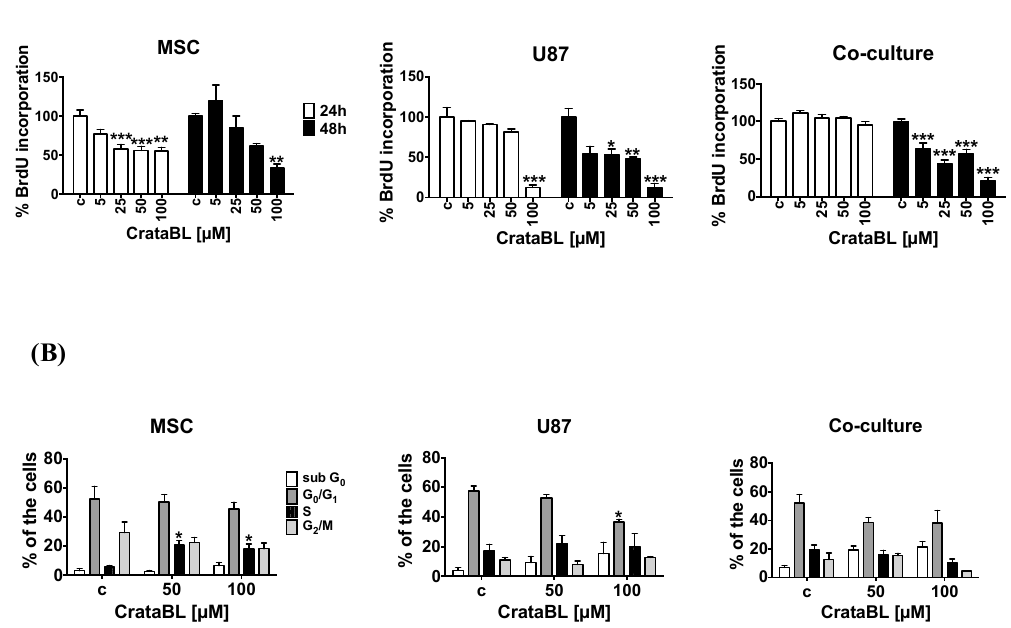
Figure 2. Effects of CrataBL on the proliferation of MSCs, U87 cells, and cocultured cells. Proliferation was determined by cell cycle assay using flow cytometry. Panels represent ( A ) MSC, U87 glioblastoma cells, and direct cocultured cells, in the presence of increasing concentrations of CrataBL inhibitor as measured by BrdU assay, relative (%) to nontreated control cells (c). Cell cycle phase distribution was determined by propidium iodide staining followed by flow cytometry analyzes ( B ). Panels represent MSC, U87 GB cells, and cocultured cells, treated with CrataBL (50 µM and 100 µM) for 24 h and then permeabilized. Percentages of cells in sub G 0 , G 0 /G 1 , S, and G 2 /M phase were determined using Accuri C6 cytometer, with at least 10,000 events collected. Significance was considered at * p < 0.05, ** p < 0.005, and *** p < 0.0005.